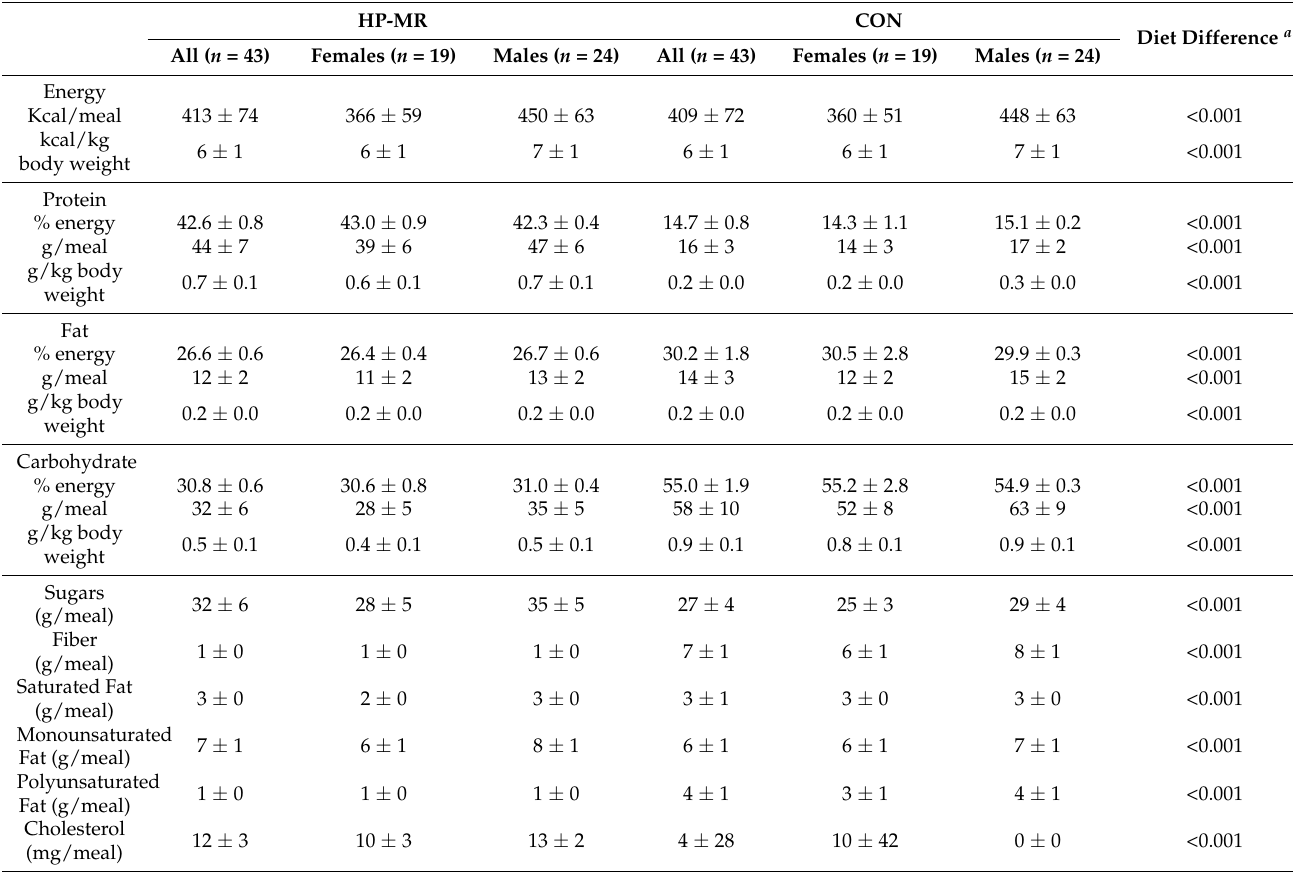
Table 1. Nutrient content of the intervention